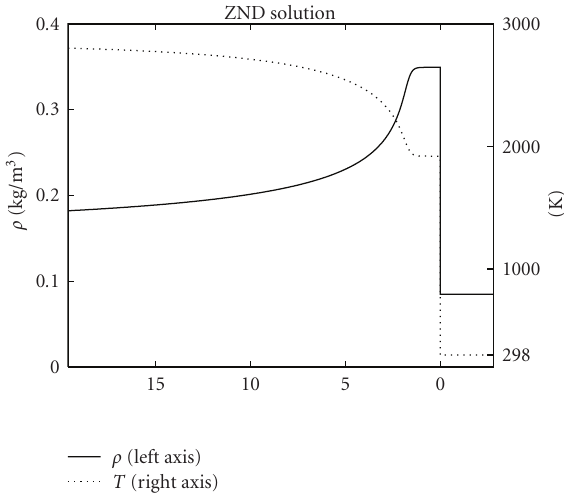
Figure 1: Density and temperature field of a self-sustaining hydrogen-oxygen detonation ( d CJ ≈ 1626 . 9m/s, l ig ≈ 1 . 404mm) calculated with the ZND theory (cf. Section 4.2). The abscissashows the distance behind the detonation front in mm.